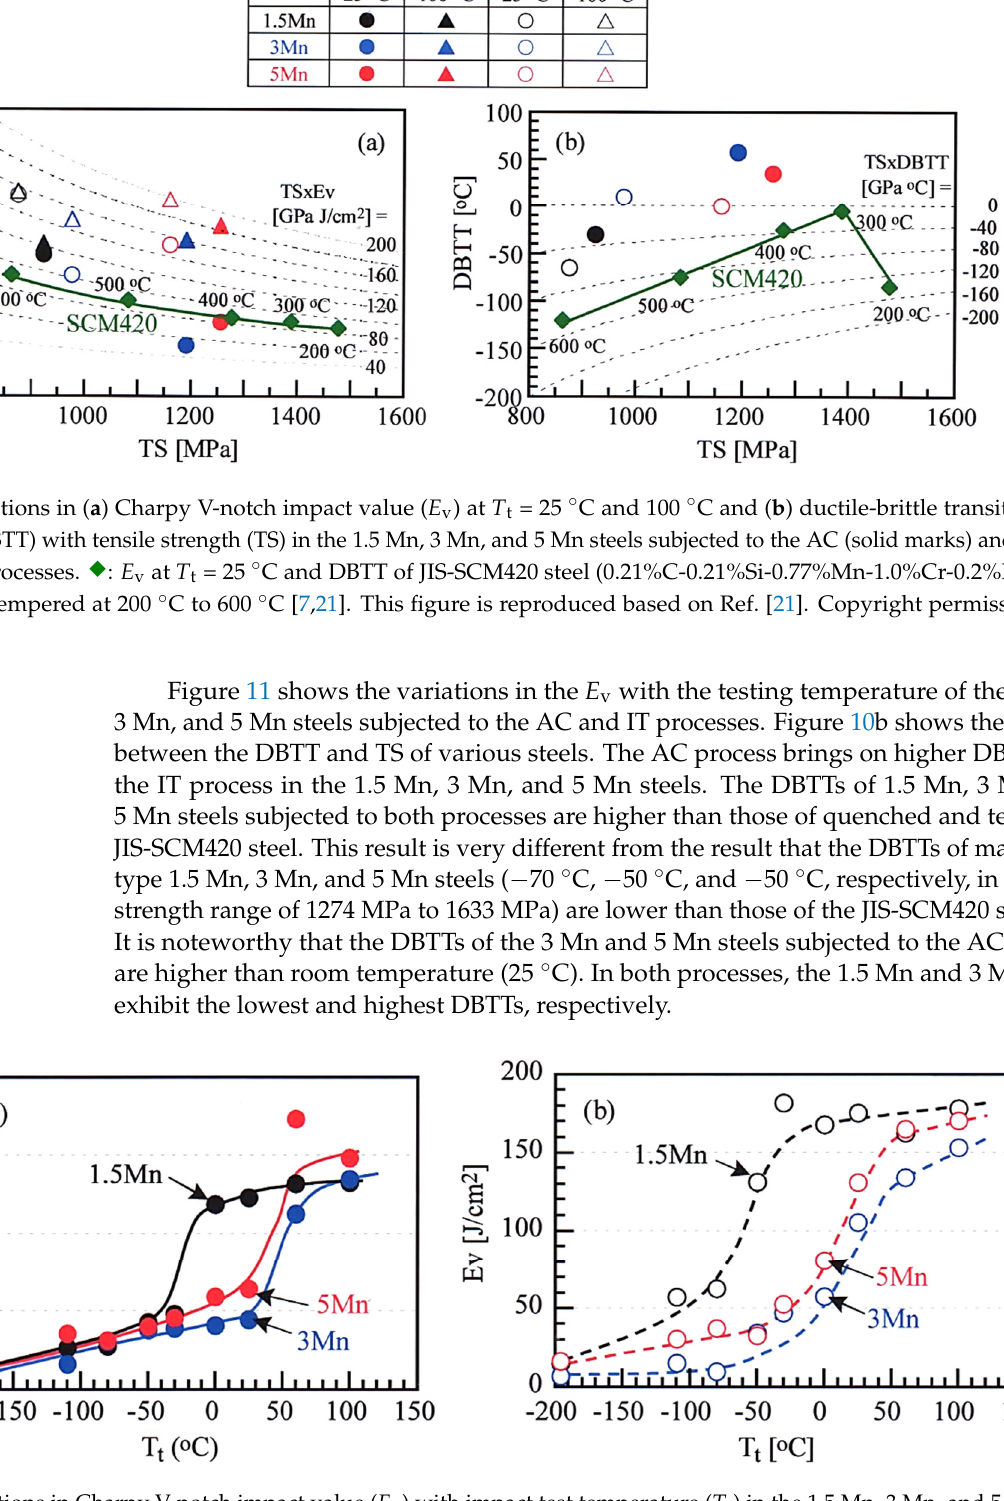
Figure 11. Variations in Charpy V-notch impact value ( E v ) with impact test temperature ( T t ) in the 1.5 Mn, 3 Mn, and 5 Mn steels subjected to ( a ) the AC and ( b ) IT processes. ( b ) is reprinted with permission from Spring Nature: Metall. Mater. Trans. A, Copyright 2021.